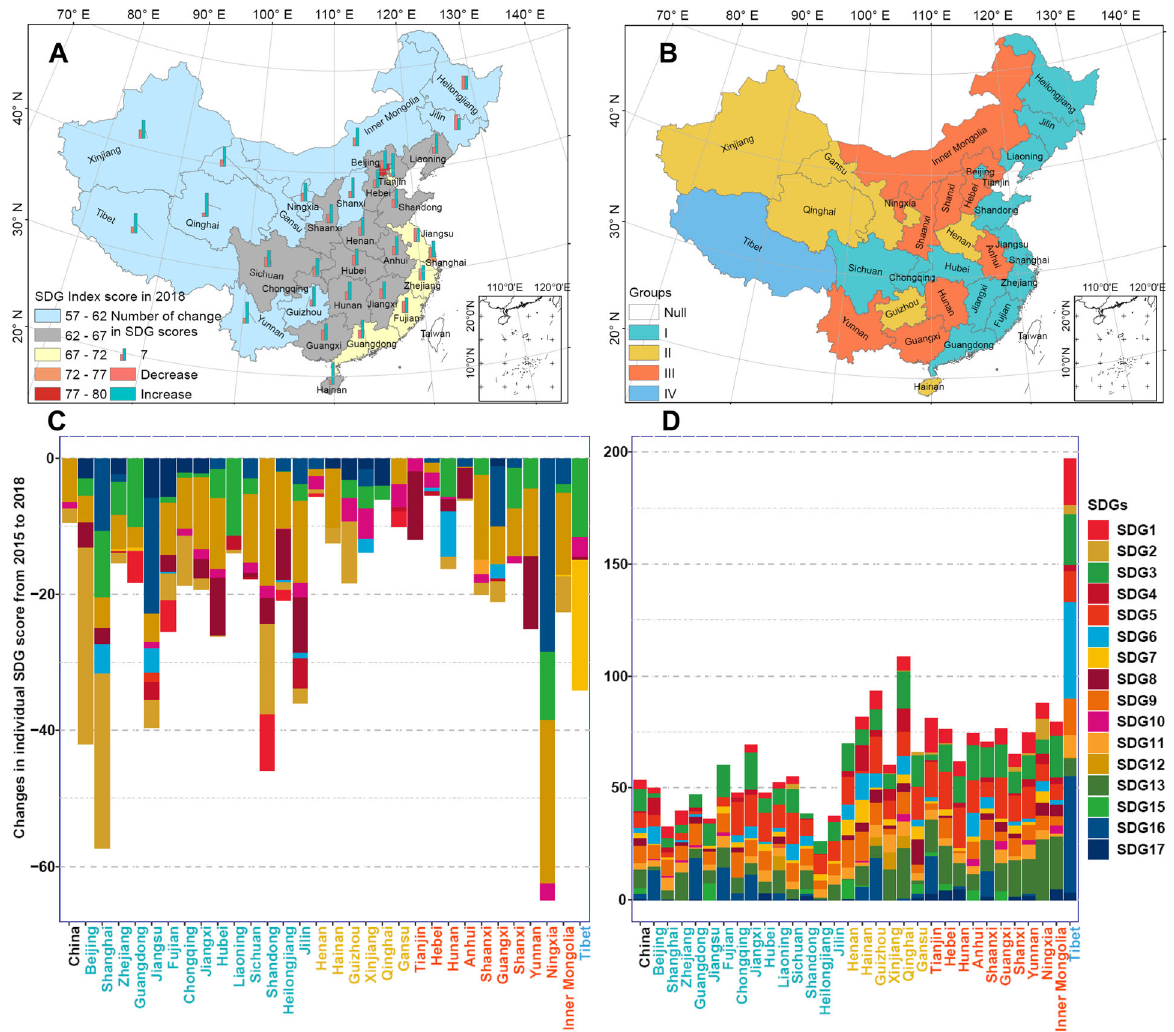
Fig. 2 Spatial characteristics of the SDG scores and their changes from 2015 to 2018 in China. A Spatial distribution of SDG index scores for 31 provinces in 2018 (polygons with different colors); light green (red) bars indicate numbers of SDGs that increased (decreased) from 2015 to 2018. B Results of cluster analysis of SDG score changes for 31 provinces from 2015 to 2018. C SDG scores that declined from 2015 to 2018 were classi fi ed into the four groups of provinces identi fi ed in the cluster analysis. D SDG scores that increased from 2015 to 2018 were classi fi ed into the four groups of provinces identi fi ed in the cluster